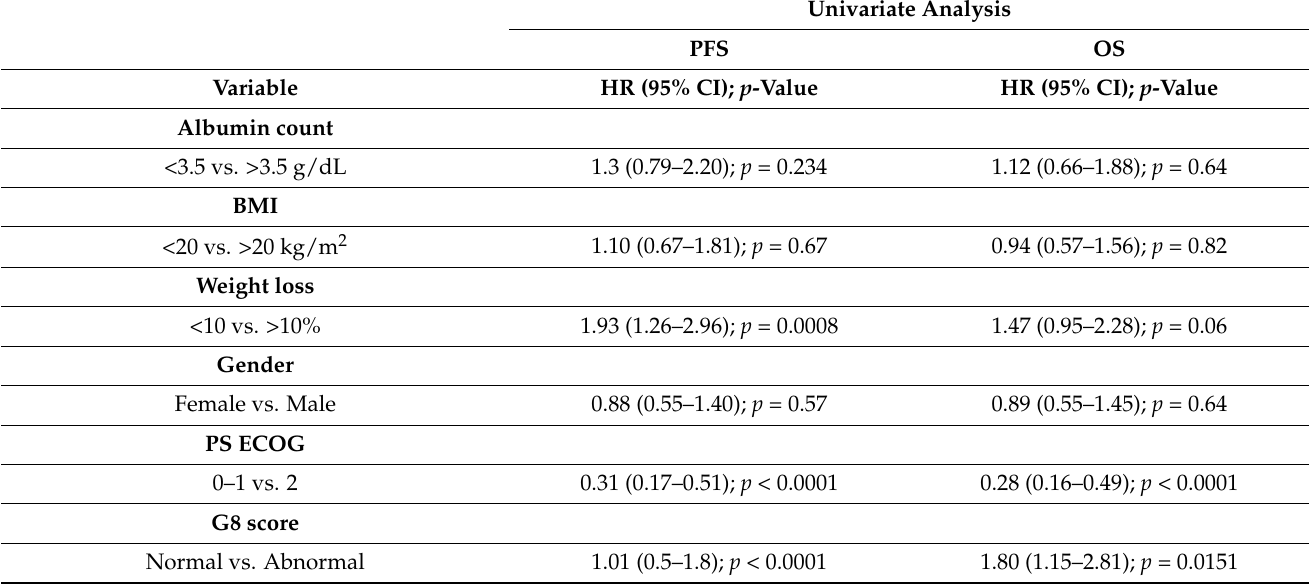
Figure 1. ( A , B ). Median PFS and OS in the whole metastatic population. Based on our univariate analysis, weight loss, G8 score, PS ECOG, and chemotherapy schedules (mono-CT vs. doublet-CT) were correlated with PFS, whereas G8 score, PS ECOG, and type of chemotherapy were correlated with OS (Table 2). The multivariate analysis G8 score and PS ECOG influenced both PFS and OS ( p = 0.0012 and p ≤ 0.0001 for PFS and p = 0.036 and p < 0.0001 for OS) (Table 3). Table 3. Univariate and multivariate analysis.